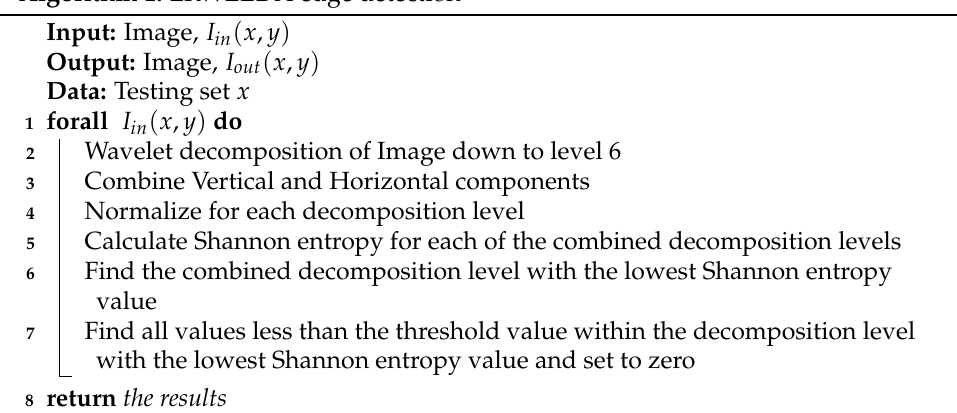
Algorithm 1: LRWEEDA edge